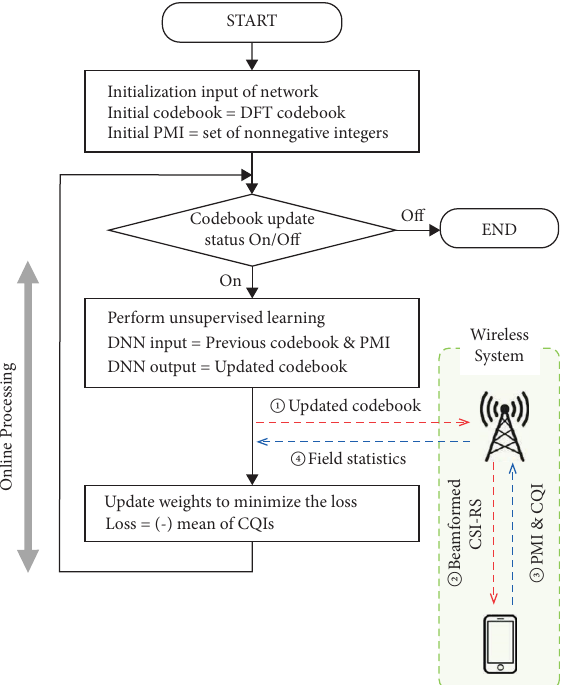
Figure 2: Algorithm fowchart for the autonomous codebook generation.